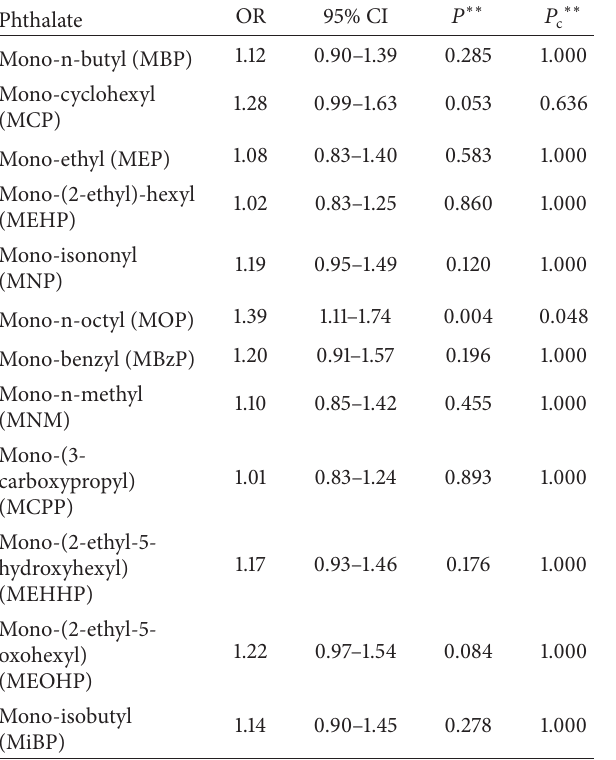
Table 3: Multivariable association of MOP with self-reported eye affliction/retinopathy through nested logistic regression models, NHANES 2001–2010 ∗ .